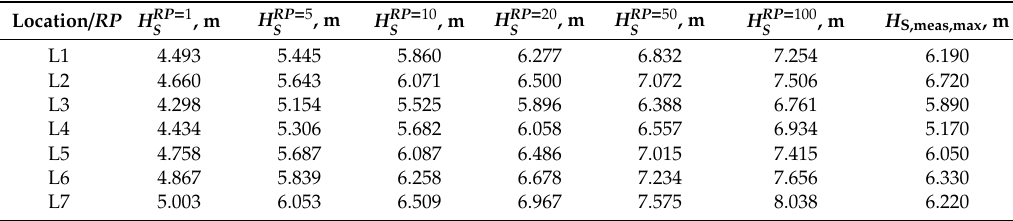
Figure 8. Comparison between measured data and the 3-parameter Weibull CDF. Table 6. The obtained extreme values of H S .